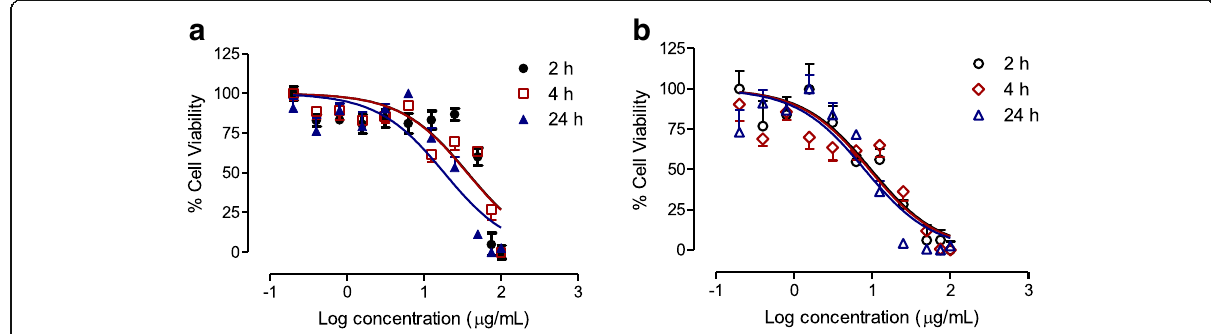
Fig. 4 Sigmoidal growth curves for ( a ) BC-S and ( b ) BC-NE venoms (100 – 0.2 μ g/mL) after 2, 4 or 24 h of incubation in HEK-293 cells ( n = 4)